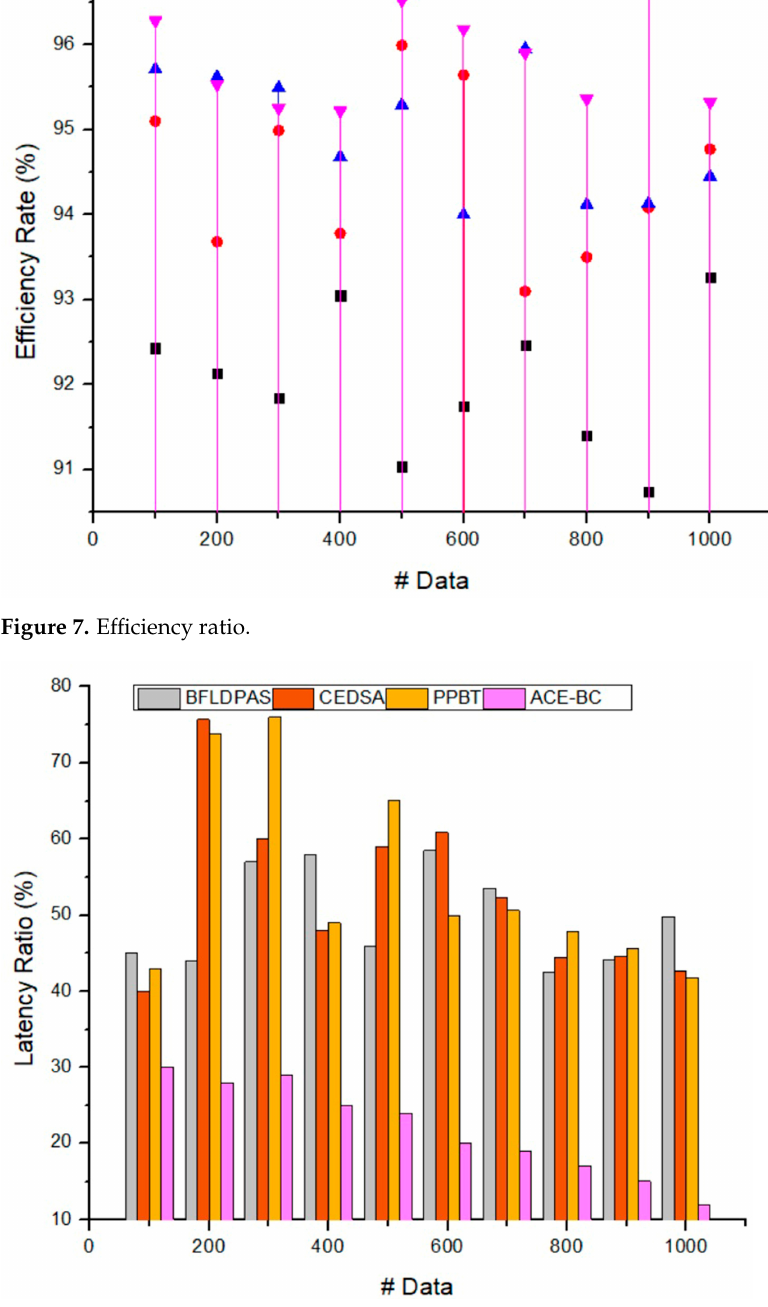
Figure 8. Latency